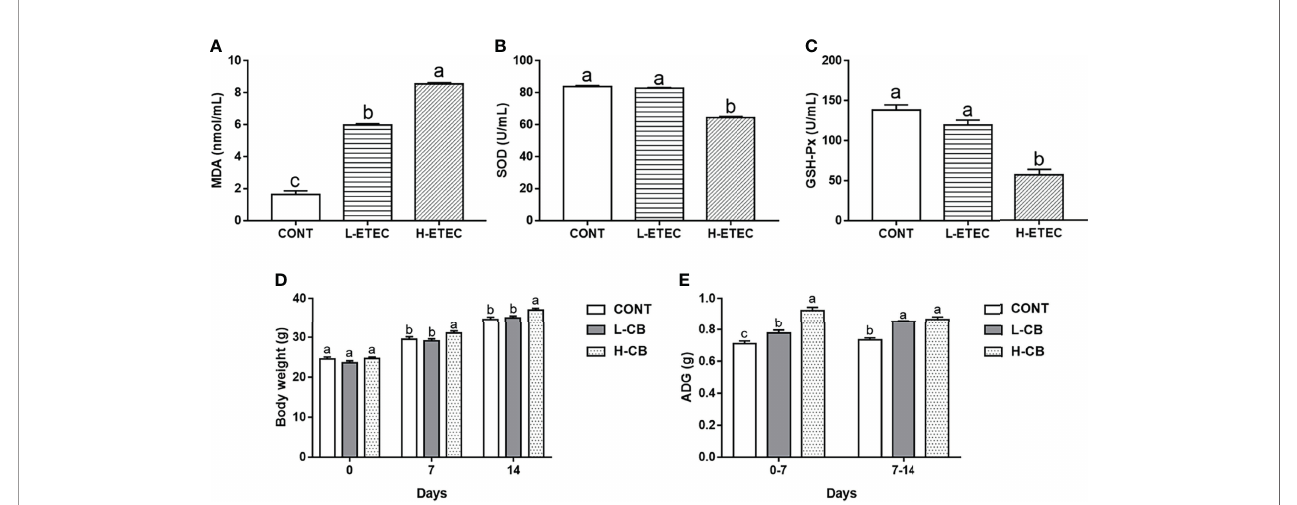
FIGURE 1 | Effects of different levels of ETEC on (A) MDA, (B) SOD, and (C) GSH-Px in the serum of mice (n = 6 mice per group). Effects of different levels of CB on (D) body weight and (E) average daily gain of mice (n = 16 mice per group). Values shown are the means ± SEM. Different small letters indicate signi fi cant differences ( p < 0.05).